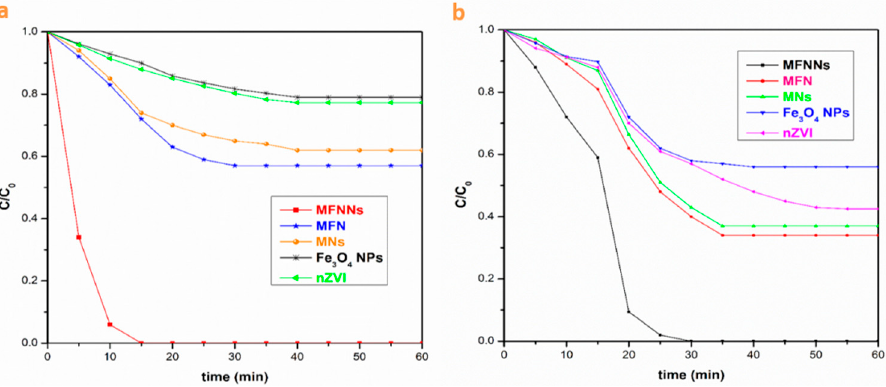
Figure 8. Effect of catalyst species on the simultaneous removal of ( a ) Cr(VI) and ( b ) 4-CP. (Experiment conditions: [Cr(VI)] 0 = 10.0 mg/L, [4-CP] 0 = 100.0 mg/L,[catalyst]= 0.20 g/L, [H 2 O 2 ] 0 = 4.90 mM, pH = 3.0).